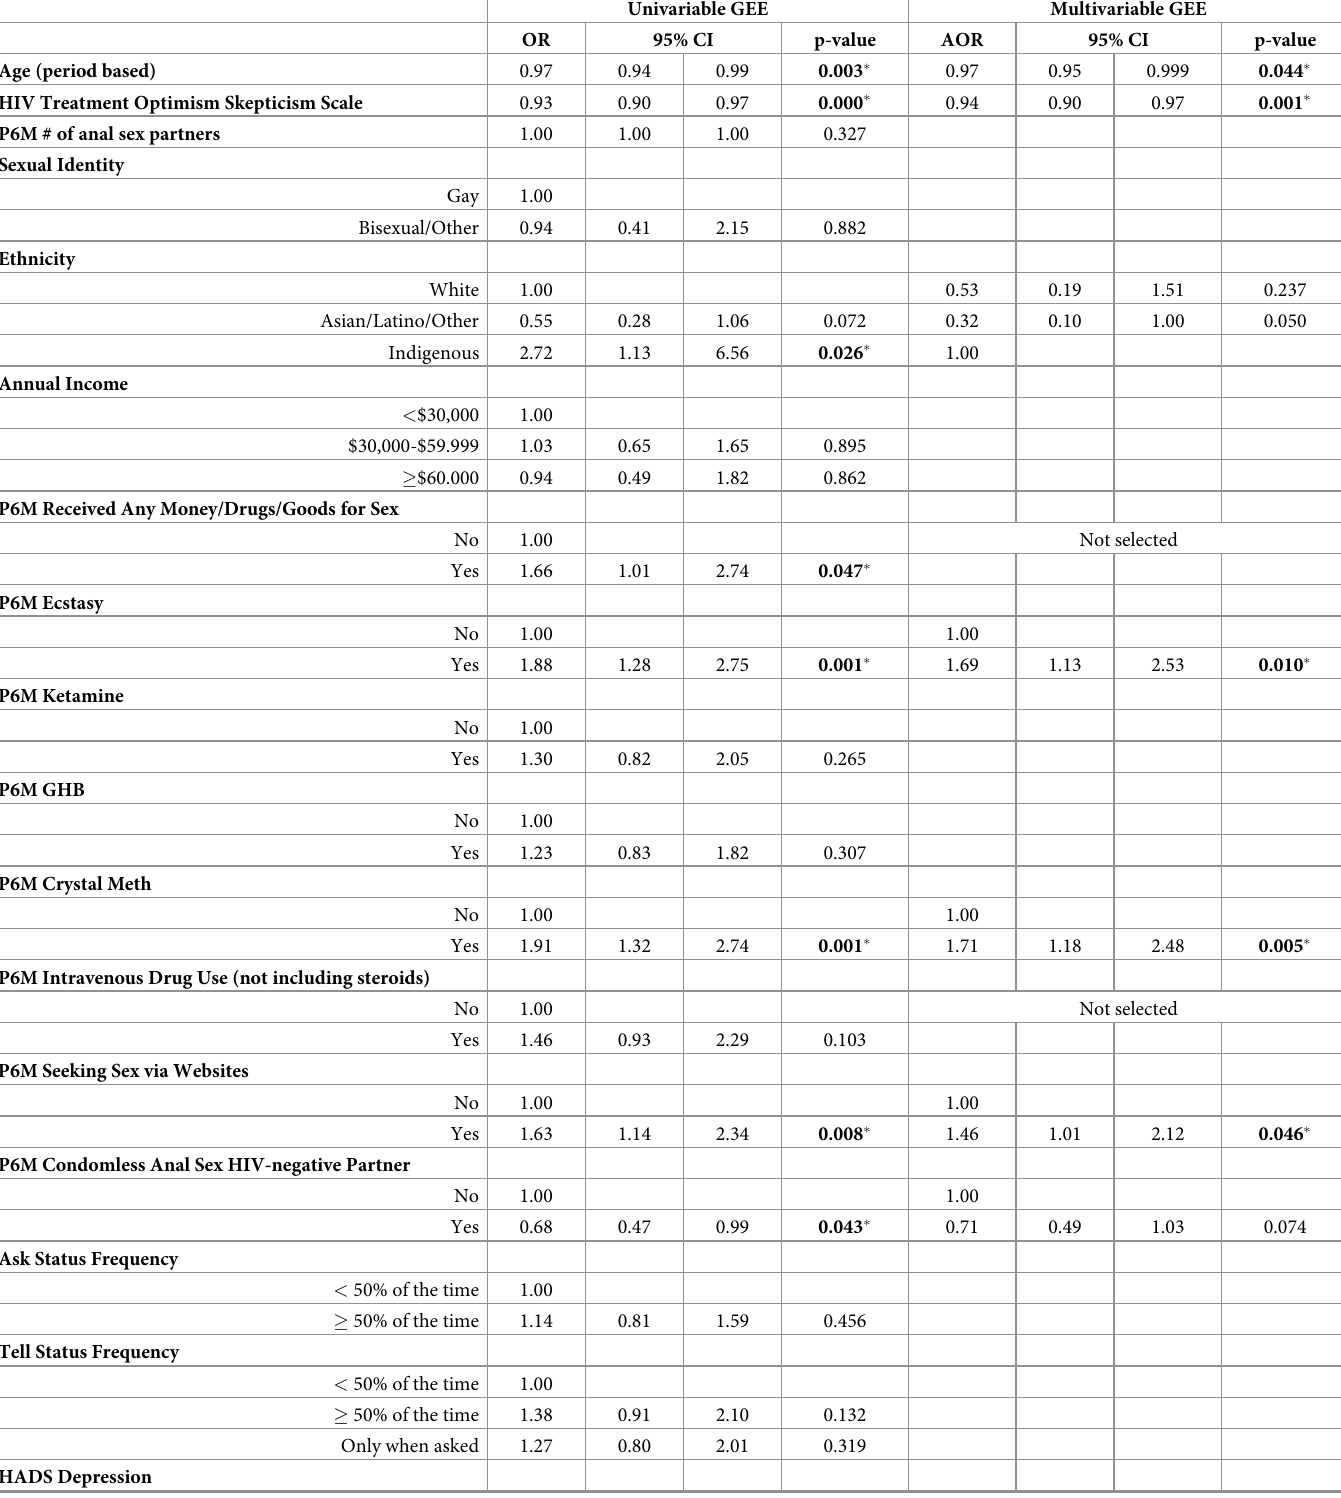
Table 2. Factors associated with episodes of VL � 200 copies/mL over